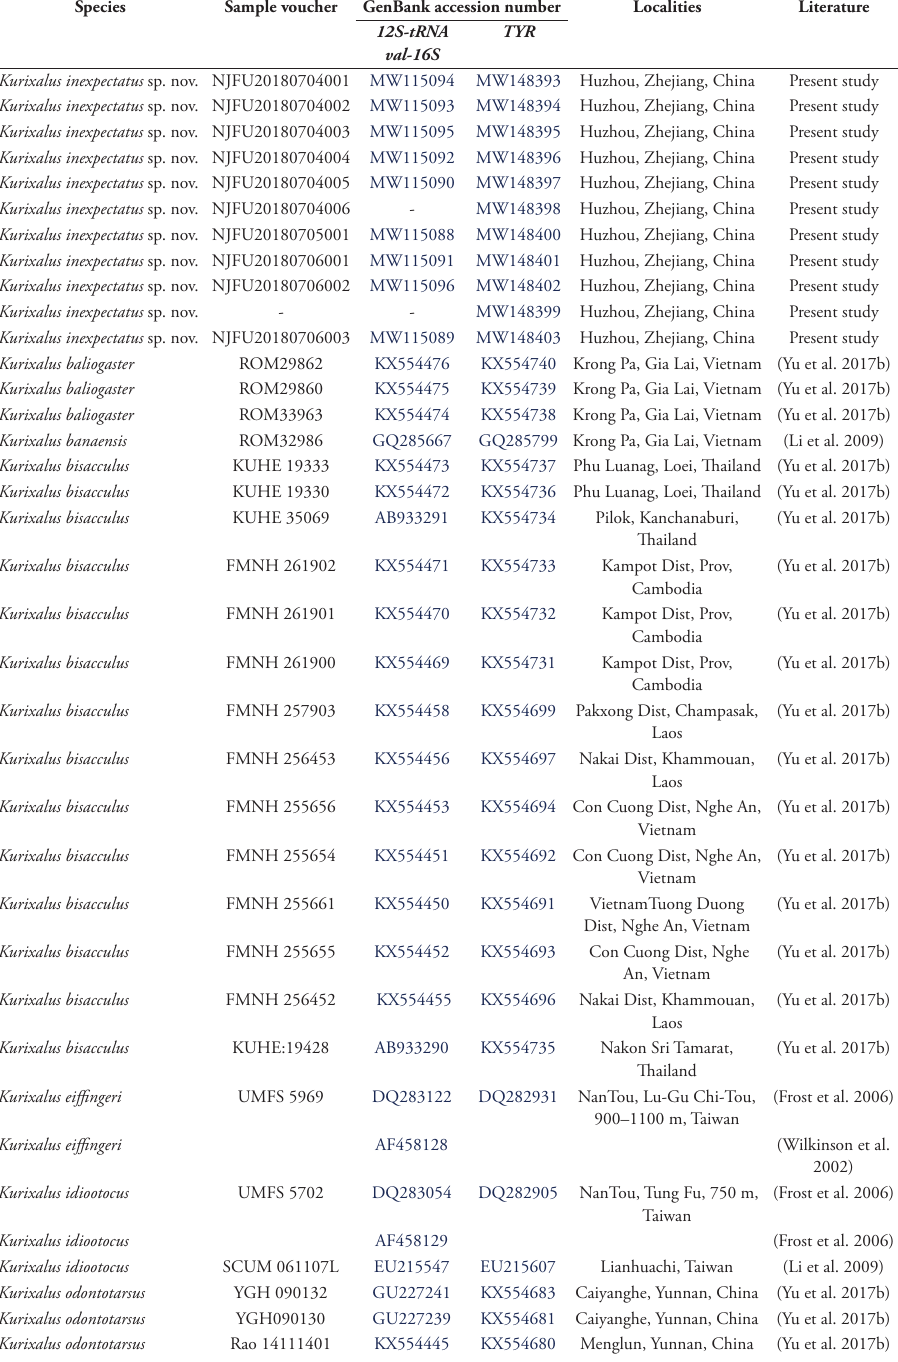
Table 1. Samples and sequences used as taxa for the phylogenetic trees in this